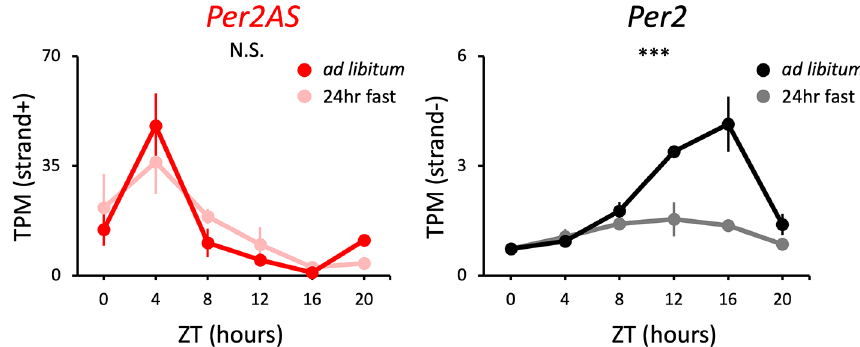
Figure 2. The expression patterns of Per2AS and Per2 under ad libitum or 24-hr fasting conditions. Mice were keptunderanL:D=12:12cycleandeitherfed adlibitum orfoodwasremoved24hourspriortotissuesamplingforthe fasting group of mice. Liver RNAs were extracted every four hours. Points and error bars represent mean (cid:2) SE (n=3). (***) p<0.001, N.S. indicates no significant difference between feeding conditions (two-way ANOVA). Data derived from Kinouchi et al. , Cell Rep. , 2018.